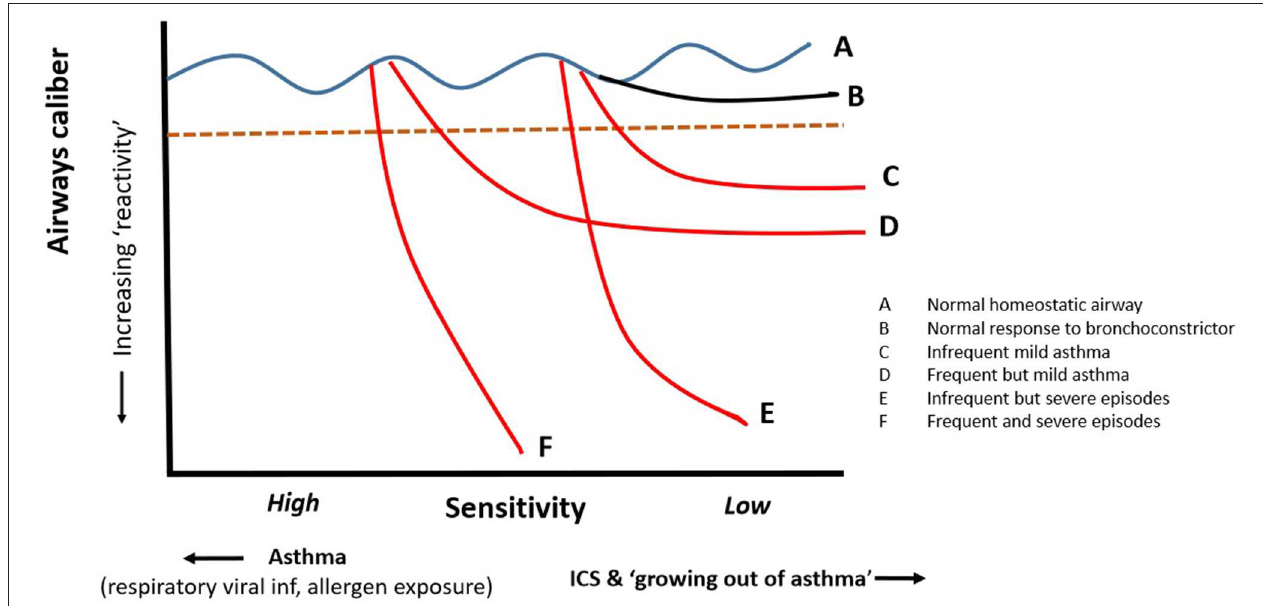
FIGURE 2 | Bronchial hyper-responsiveness consists of two components; how sensitive the airways are to agonists driving shortening of ASM and how much the ASM shorten when the normal homeostatic mechanisms fail. The impact of shortening can be amplified in presence of significant airways secretions and plugging. The sensitivity and reactivity of vary between asthmatics and probably accounts for different patterns of symptoms from mild frequent to infrequent severe. Steroids have significant effects on sensitivity but may have little or no effect on reactivity once destabilization is